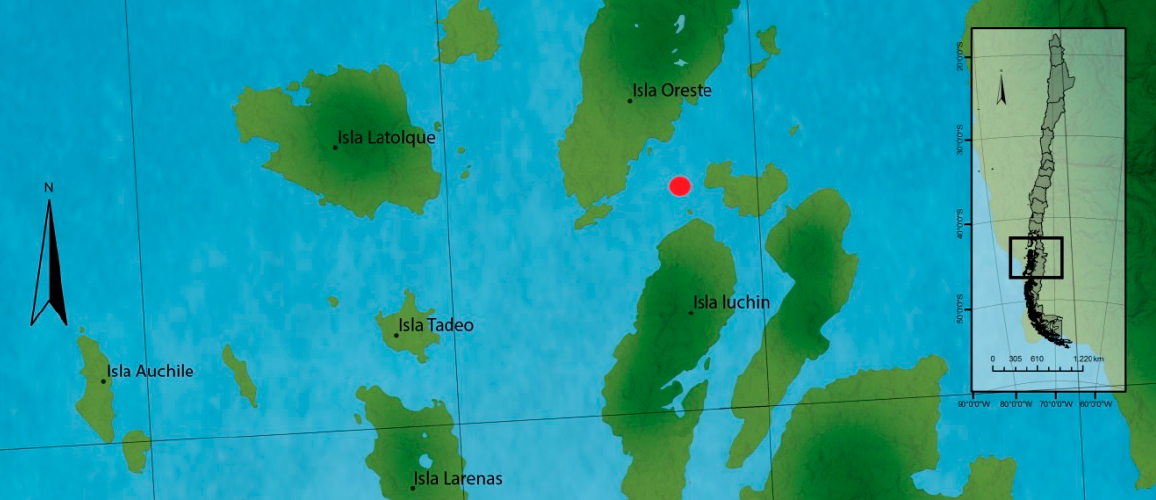
Figure 2. Sampling site for dinoflagellates, bivalves, and carnivorous gastropods near Huichas Island, Aysén Region, Chile.